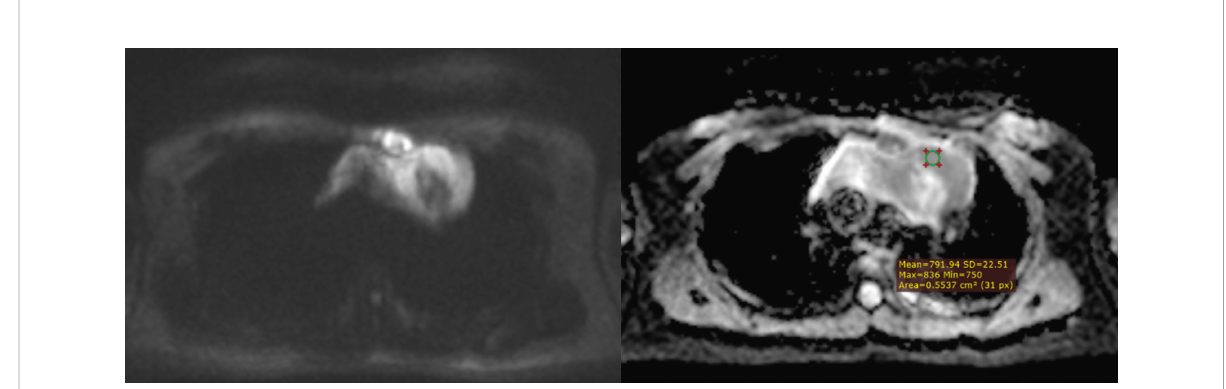
FIGURE 10 Mediastinal diffuse large B-cell lymphoma. A mediastinal diffuse large B-cell lymphoma having areas of restricted diffusion, which were hyperintense on DWI (b = 2000 sec/mm2) and correspondingly hypointense on ADC map. The mean of 3 ADC values obtained by using the hot-spot-ROI-based approach was 0.75 x 10-3